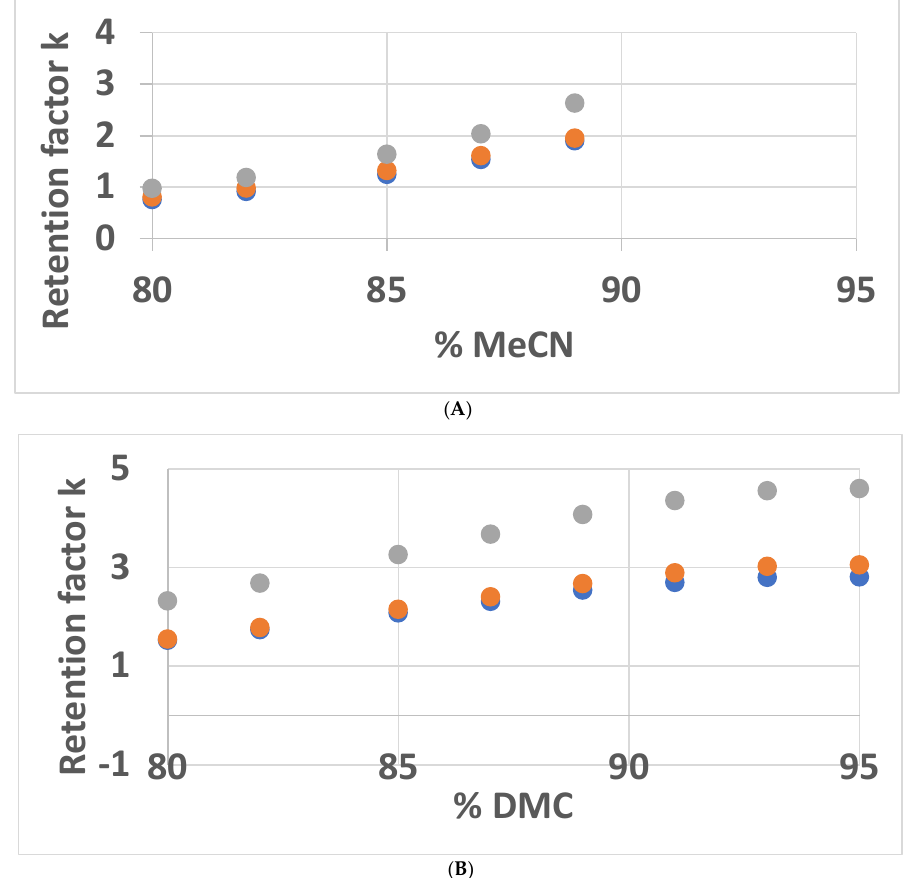
Figure 5. Retention factor vs. % organic modifier: ( A ) MeCN; ( B ) DMC. Top (gray) - syringic acid; middle (orange) - trans-ferulic acid; bottom (blue) - vanillic acid.